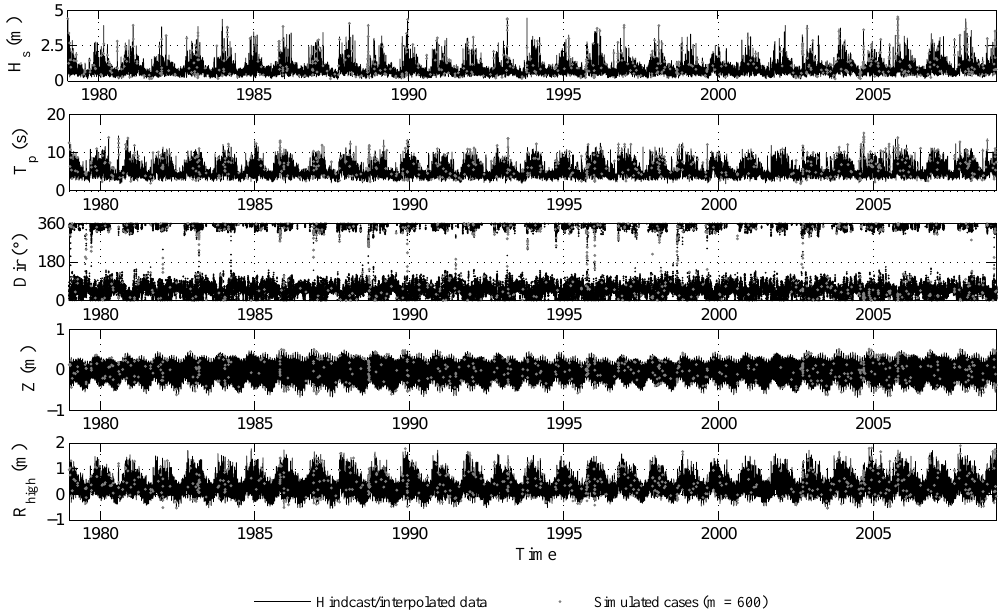
Figure 7. Time series of the wave hindcast data ( H s , T p , θ ), sea-level ( Z ), and interpolated run-up value ( R high = R 2% + Z ), indicating the selected/simulated cases.